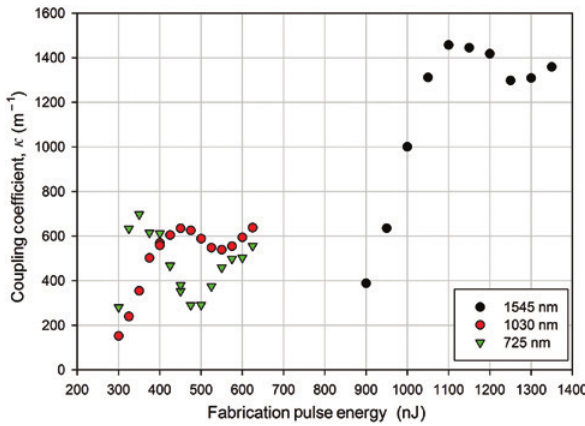
Figure 8: Coupling coefficients κ of first-order WBGs fabricated in a 4-mm-long silicate glass (Schott IOG-10) at different Bragg wavelengths λ . B